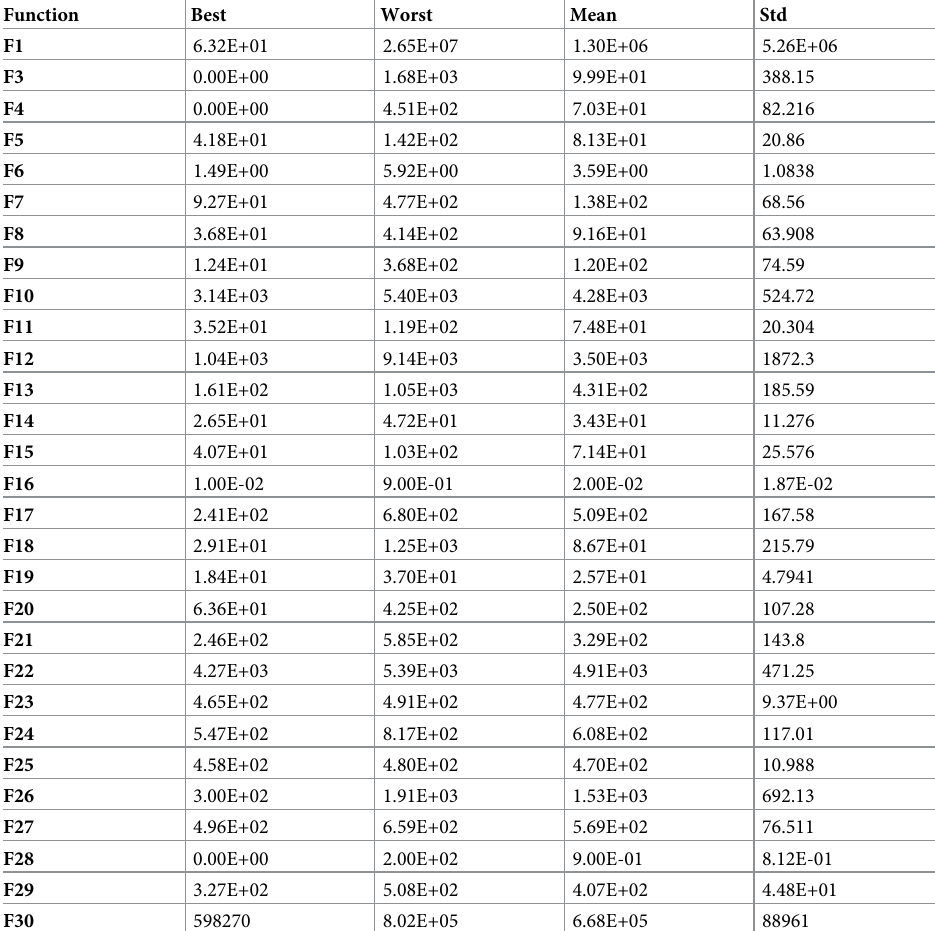
Table 8. Results for ADMO in 50